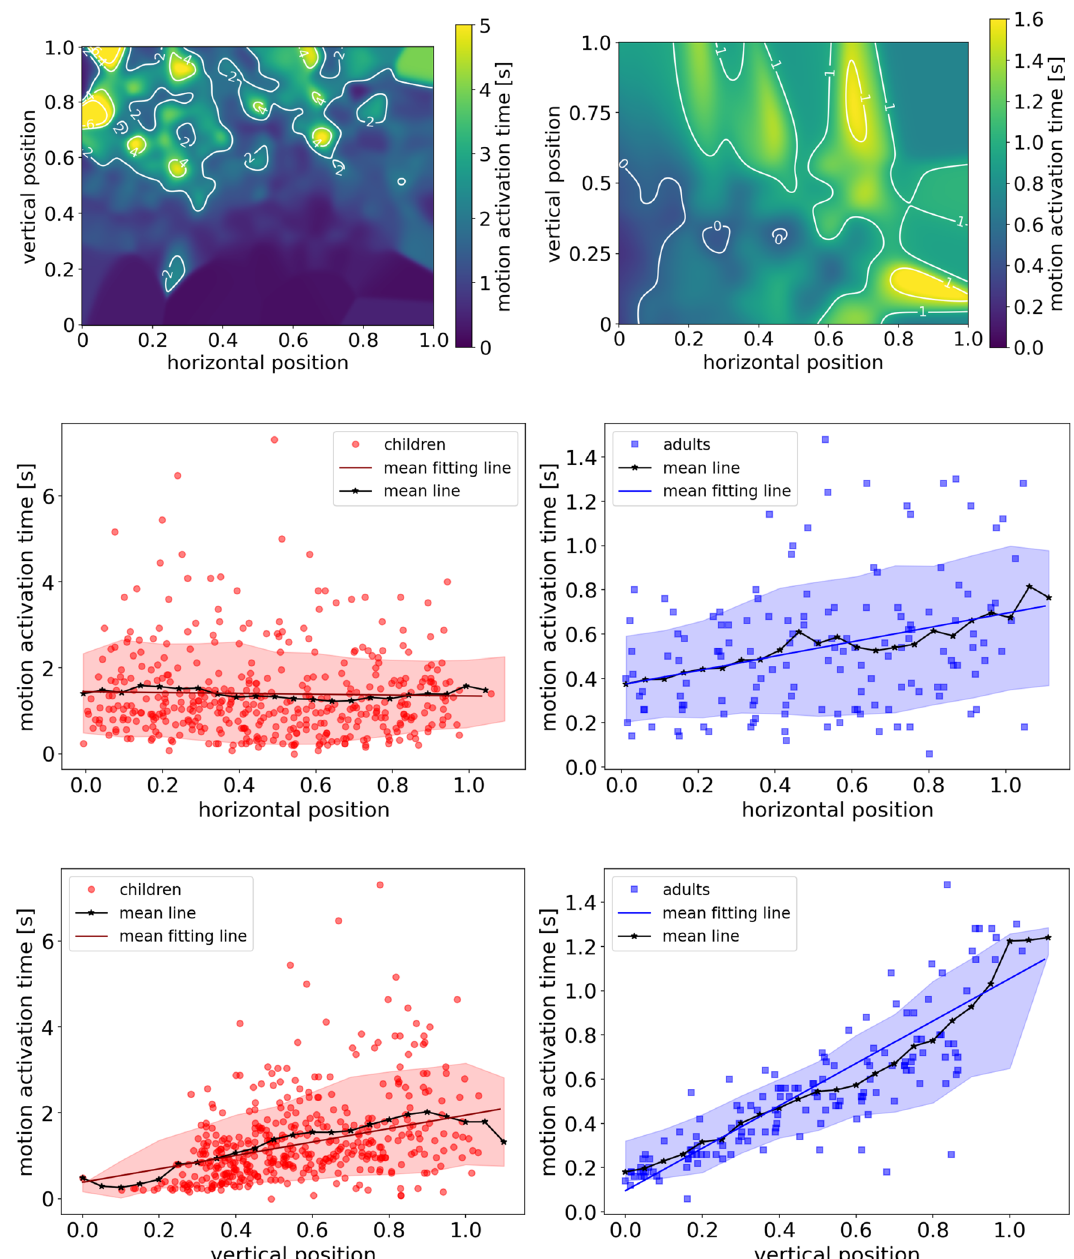
Figure 14. The influence of horizontal and vertical position on the motion activation time of pre-school children (red points) and adults (blue squares). Top row: spatial distribution in children’s (left) and adults’ (right) experiment. Middle row: for the horizontal position. Bottom row: for vertical position. Left column: for pre-school children. Right column: for adults. The black stars are the mean values of horizontal/vertical position for each bin and the colored bands give the standard error. The mean data (black stars) are obtained as the result of a vertical binning procedure 30 over a large number of measurements. The bin size is set as 0.05. The black lines highlight the mean data trend and the red/blue lines show the linear fitting results. Note that some points are located beyond 100%, which is due to that some pedestrians stand outside the waiting